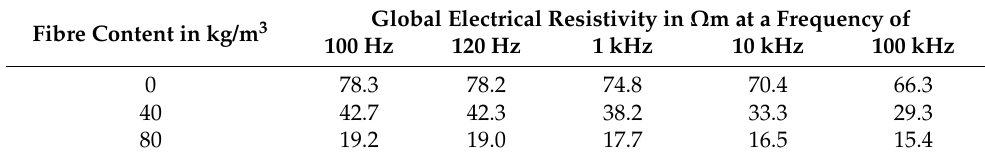
Table A40. Results of the resistivity measurements of the concrete mixture 32-60-300-00 after storage in H 2 O for 185 days for the investigations of possible leaching effects.